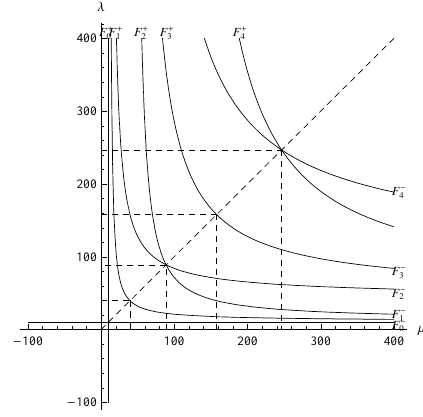
Figure 1. The spectrum for the problem (1.1),